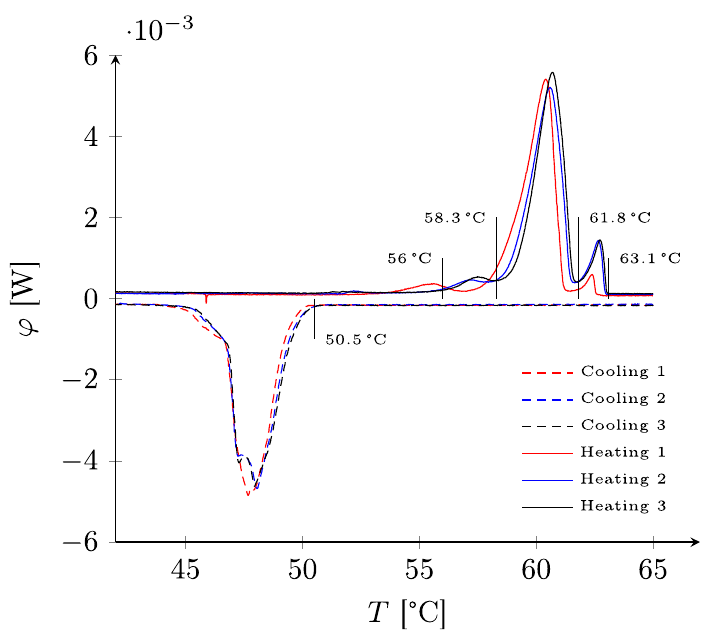
Figure 6. Thermograms for polymer PEG6000.